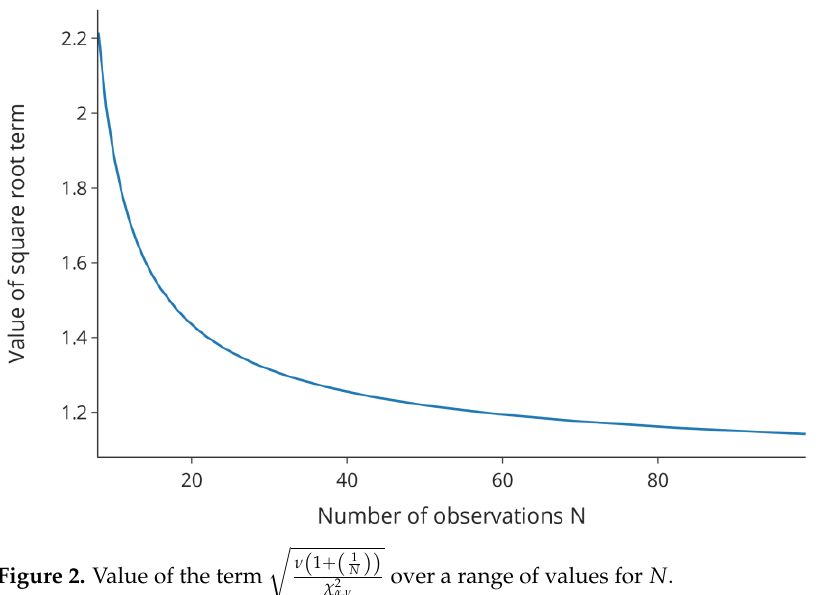
Figure 2. Value of the term √